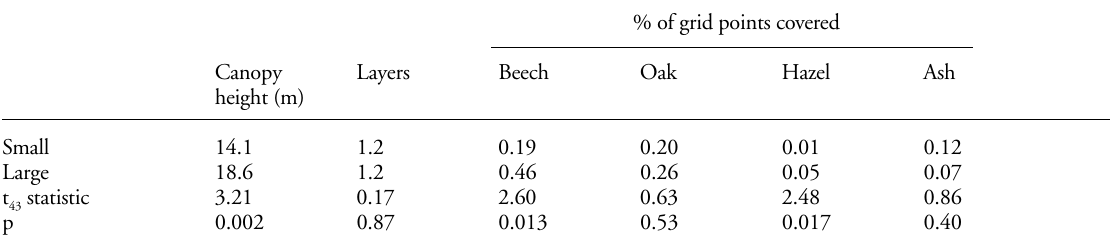
Table 3. Characteristics of woods in the two patch size classes. “Layers” is the averge number of tree species above a sampling grid point.